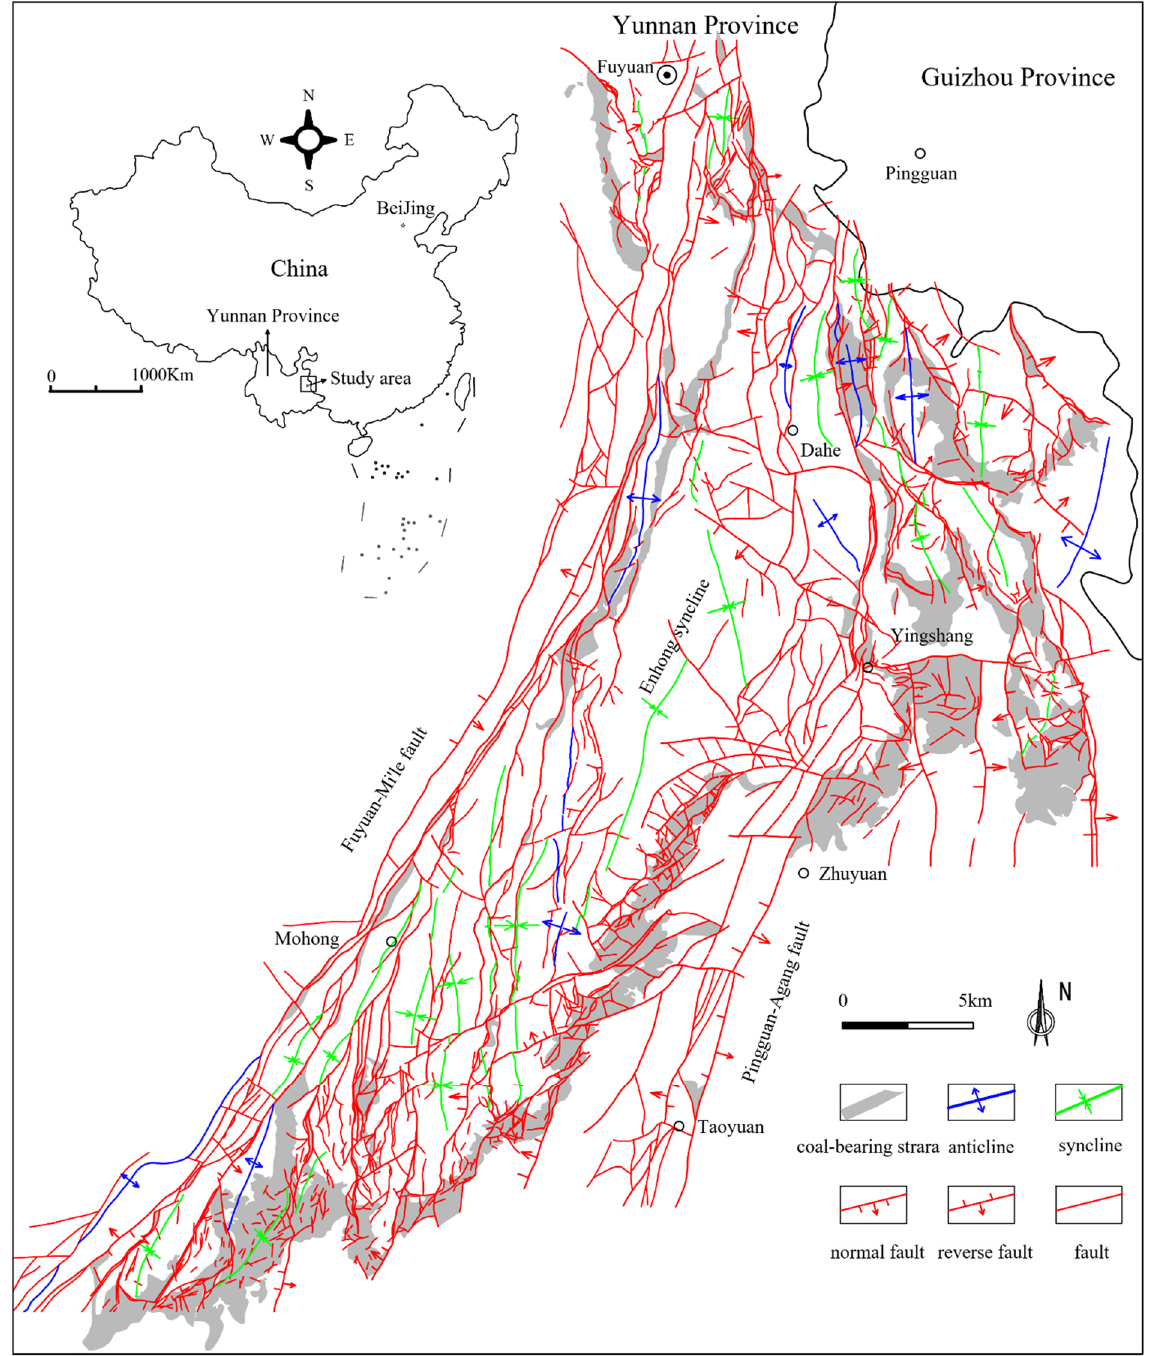
Figure 1. Structure outline of Enhong syncline.